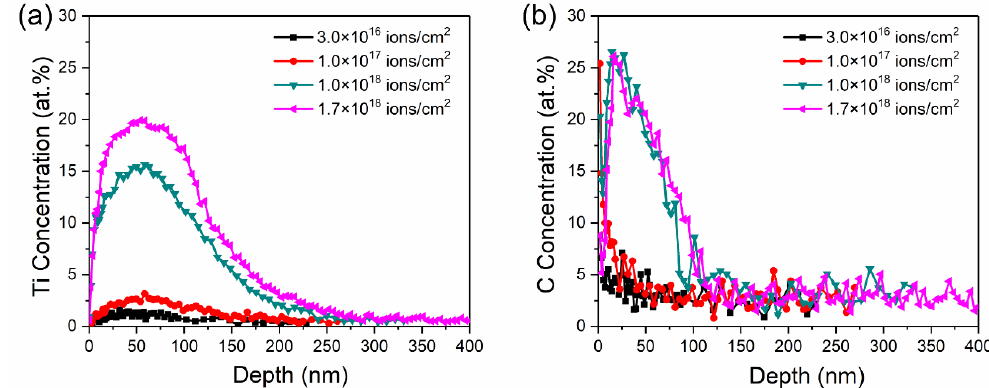
Figure 3. Elemental depth profiles of Ti ( a ) and C ( b ) of the samples with different Ti ion-implanted doses obtained by sputtering AES.